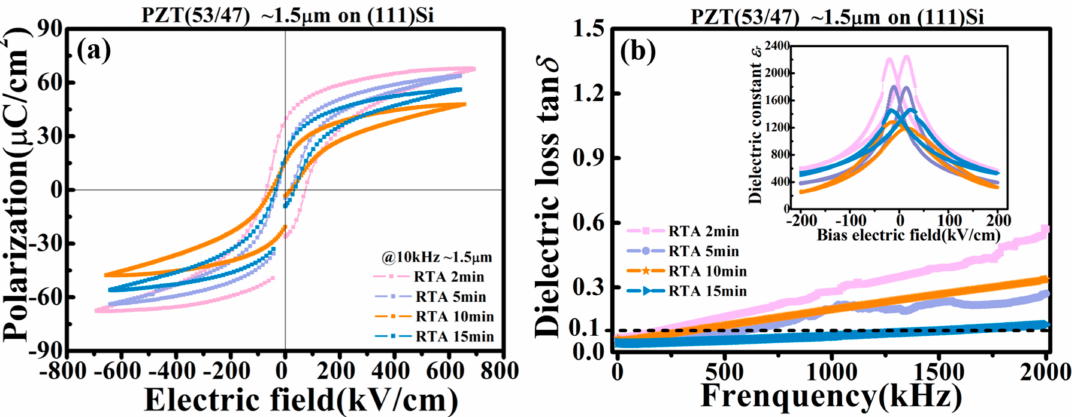
Figure 5. ( a ) Room-temperature ferroelectric P-E loops and ( b ) dielectric losses (tg δ ) as functions of the measuring frequency of the PZT films deposited on (111) Si and RTA annealed for 2–15 min; inset in ( b ) displays the dielectric constant-bias electric field ( ε r -E) curves of the PZT